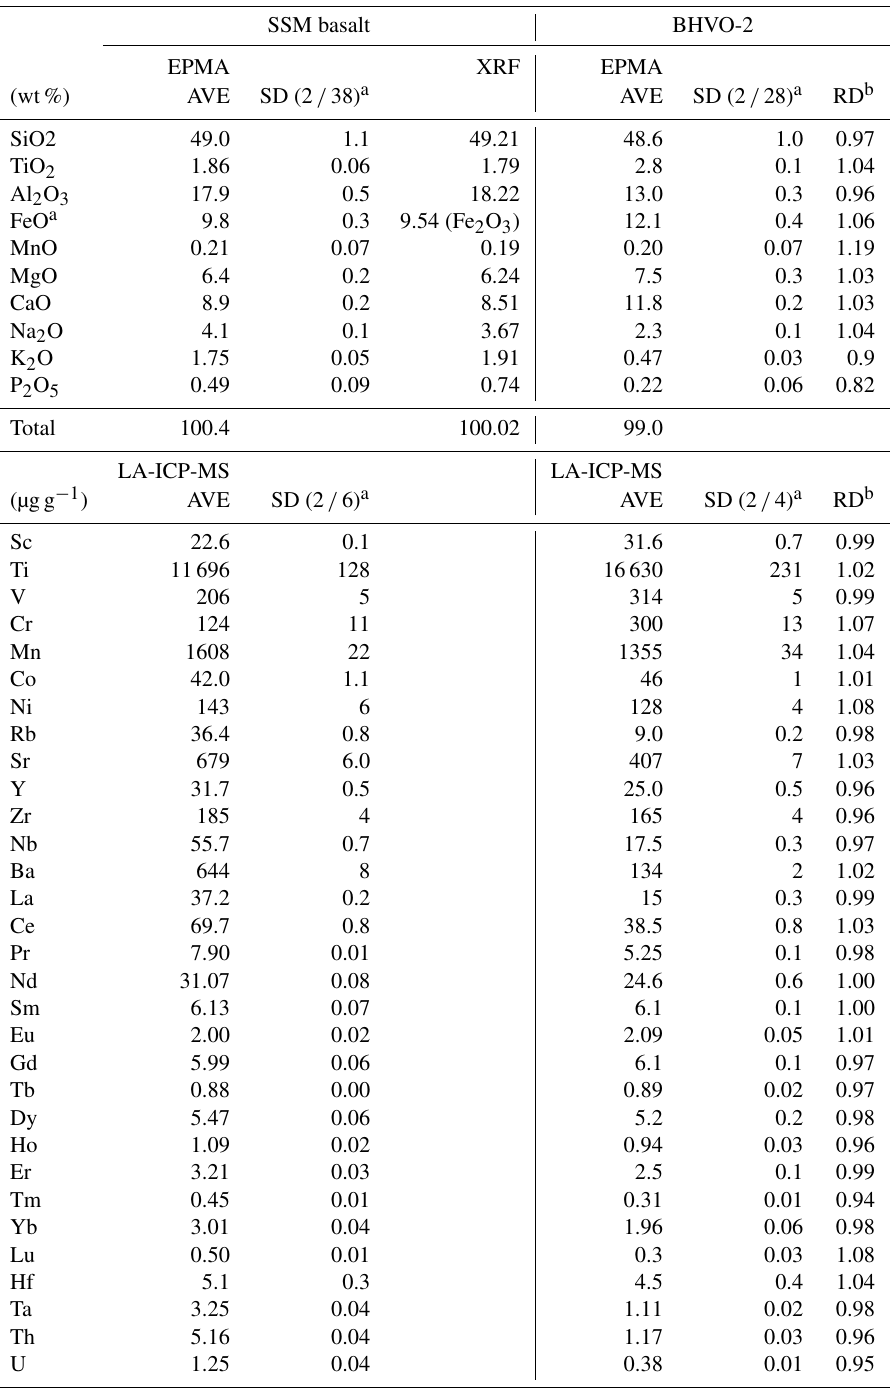
Table 1. Whole rock compositions of basalt from the Seifu